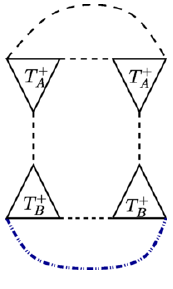
Figure 11 . Construction of genus three theory with minimal value of (cid:13)ux with G max = u (1) su (2) (cid:2) su (2).